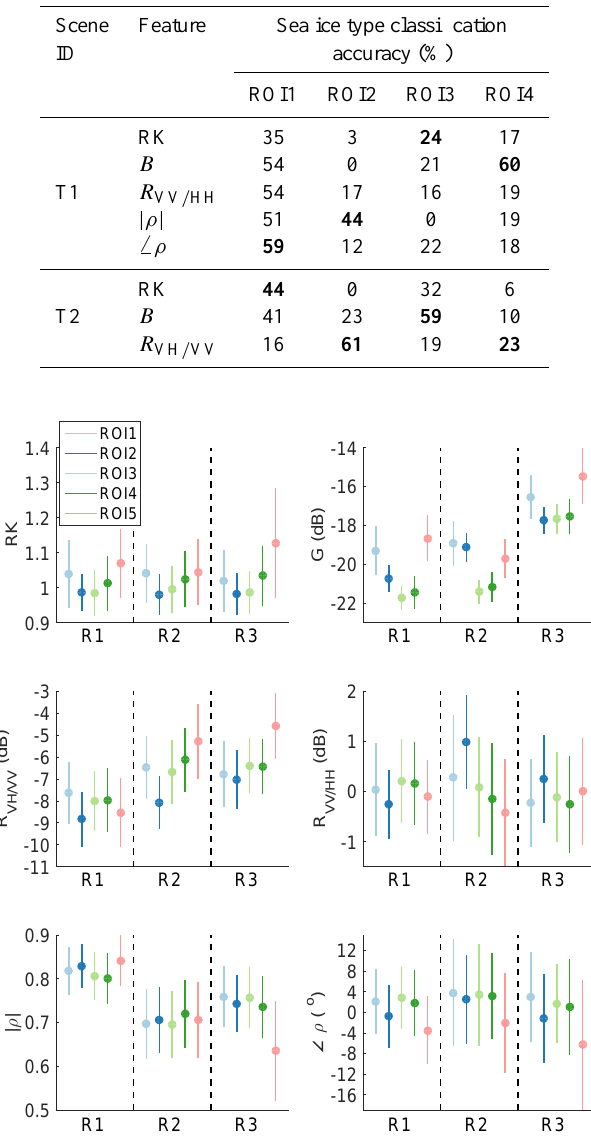
Table 4. Classification accuracy of individual polarimetric features in the three RADARSAT-2 scenes derived from MAP classification. The best result for each ROI in each scene are highlighted in bold.